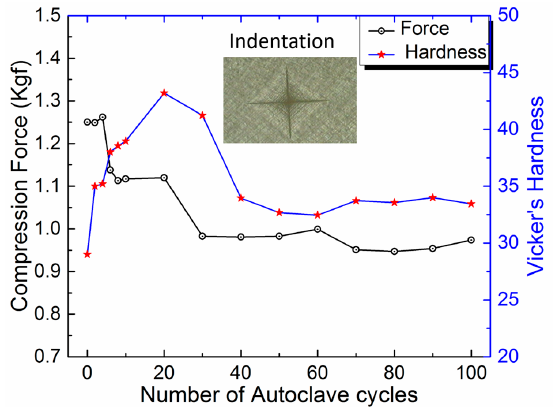
Figure 4. Change in the compression force with the hardness variation of the clip versus the number of autoclave cycles.